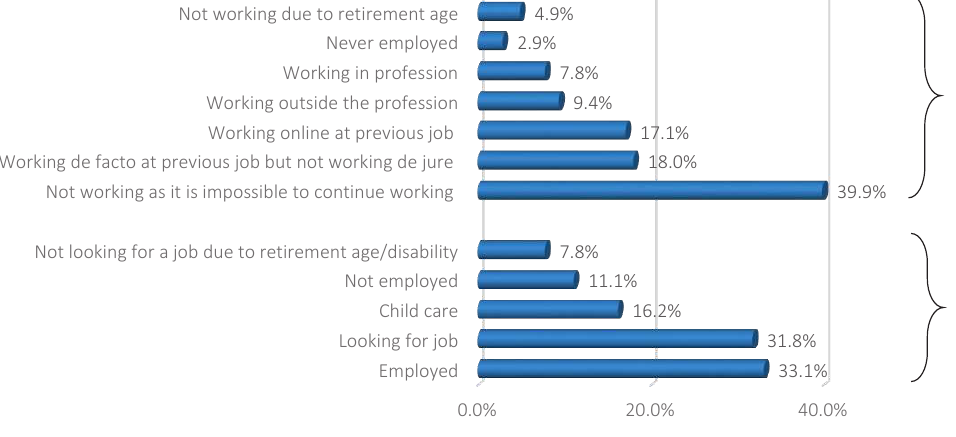
Figure 3. Current occupation status of IDPs and in the local labor market, % of